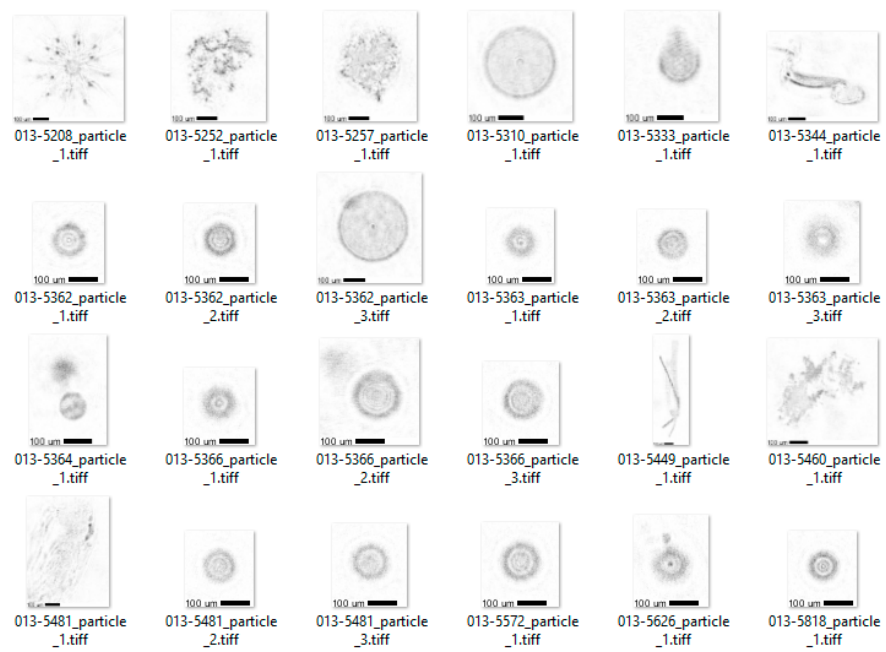
Figure 9. MP size distribution measured in Split.